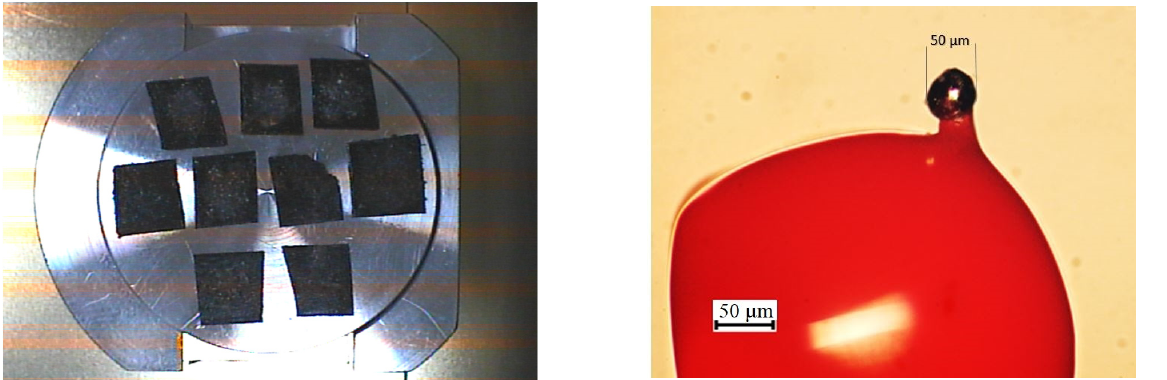
Figure 1. ( left ) Samples of meteoritic dust of Chelyabinsk meteorite in vacuum chamber of electron microscope. ( right ) Optical image of recovered carbon particle presented in Figure 2a bottom ‐ right glued on epoxy resin.